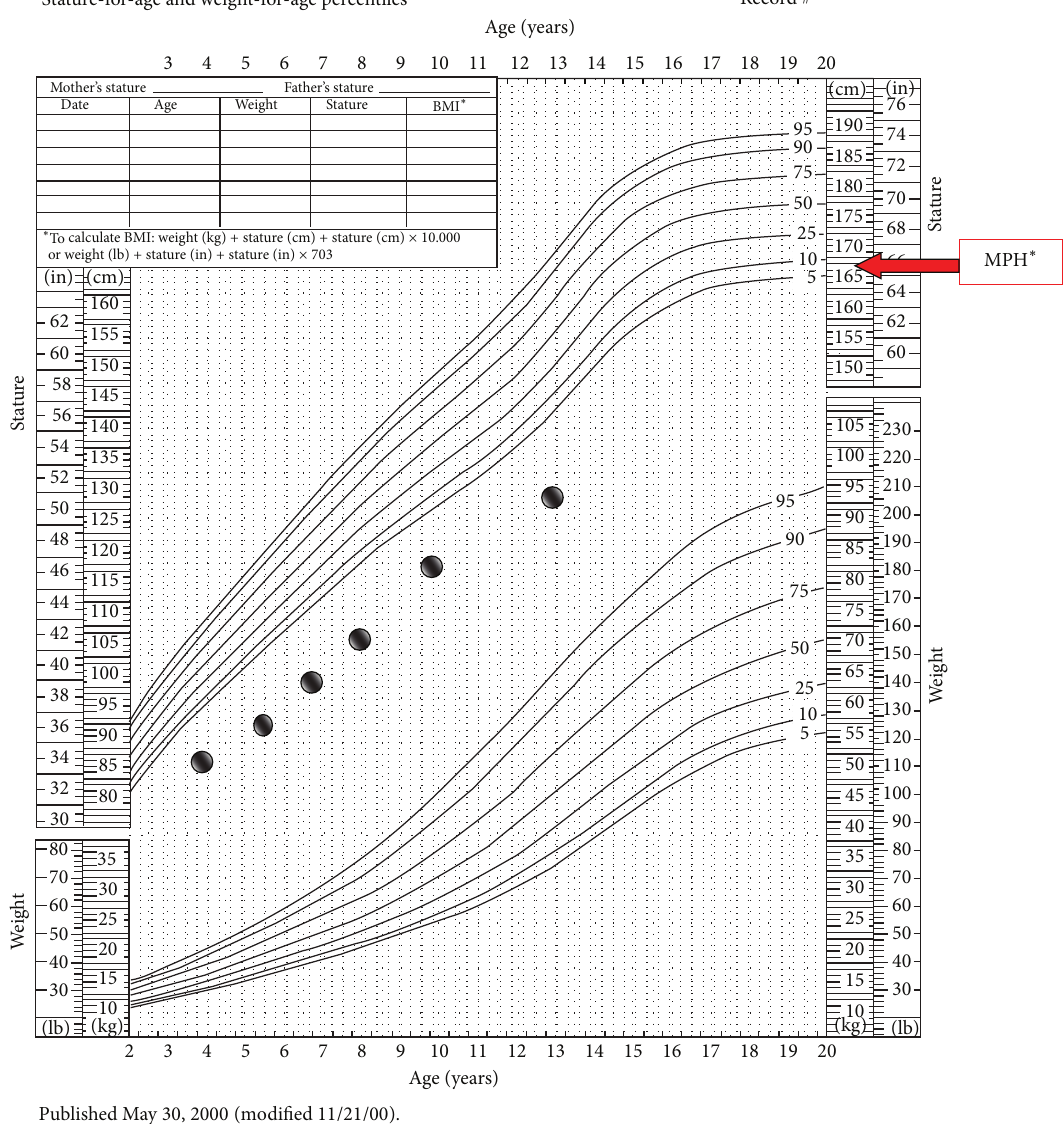
Figure 2: Patient’s growth chart. ∗ Midparental height.